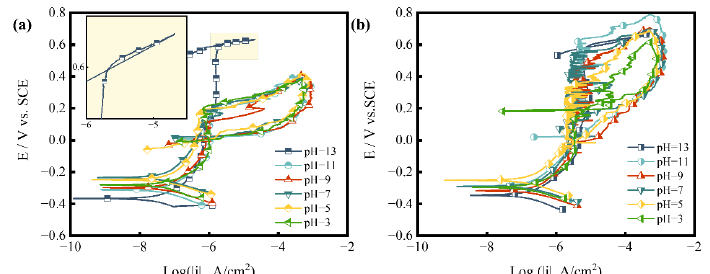
Figure 10. The cyclic polarization results tested in 0.1 mol/L NaCl at ambient temperature ( a ) the failed pipe, ( b ) standard S31608 SS.